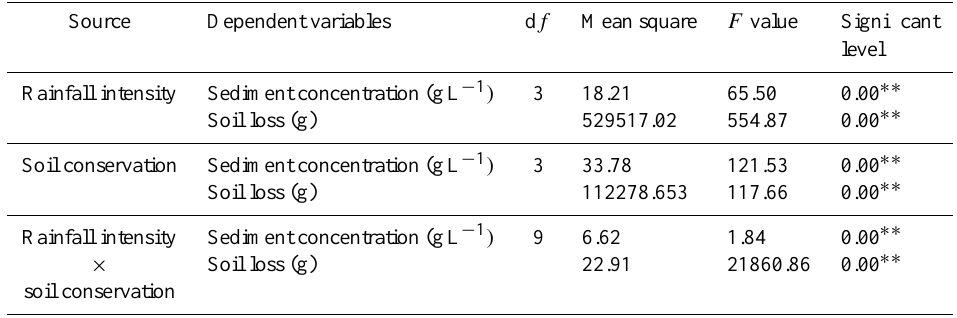
Table 4. GLM test for one-way and two-way ANOVA to calculate the effects of rainfall intensity and soil conservation treatments on sediment concentration and soil loss.